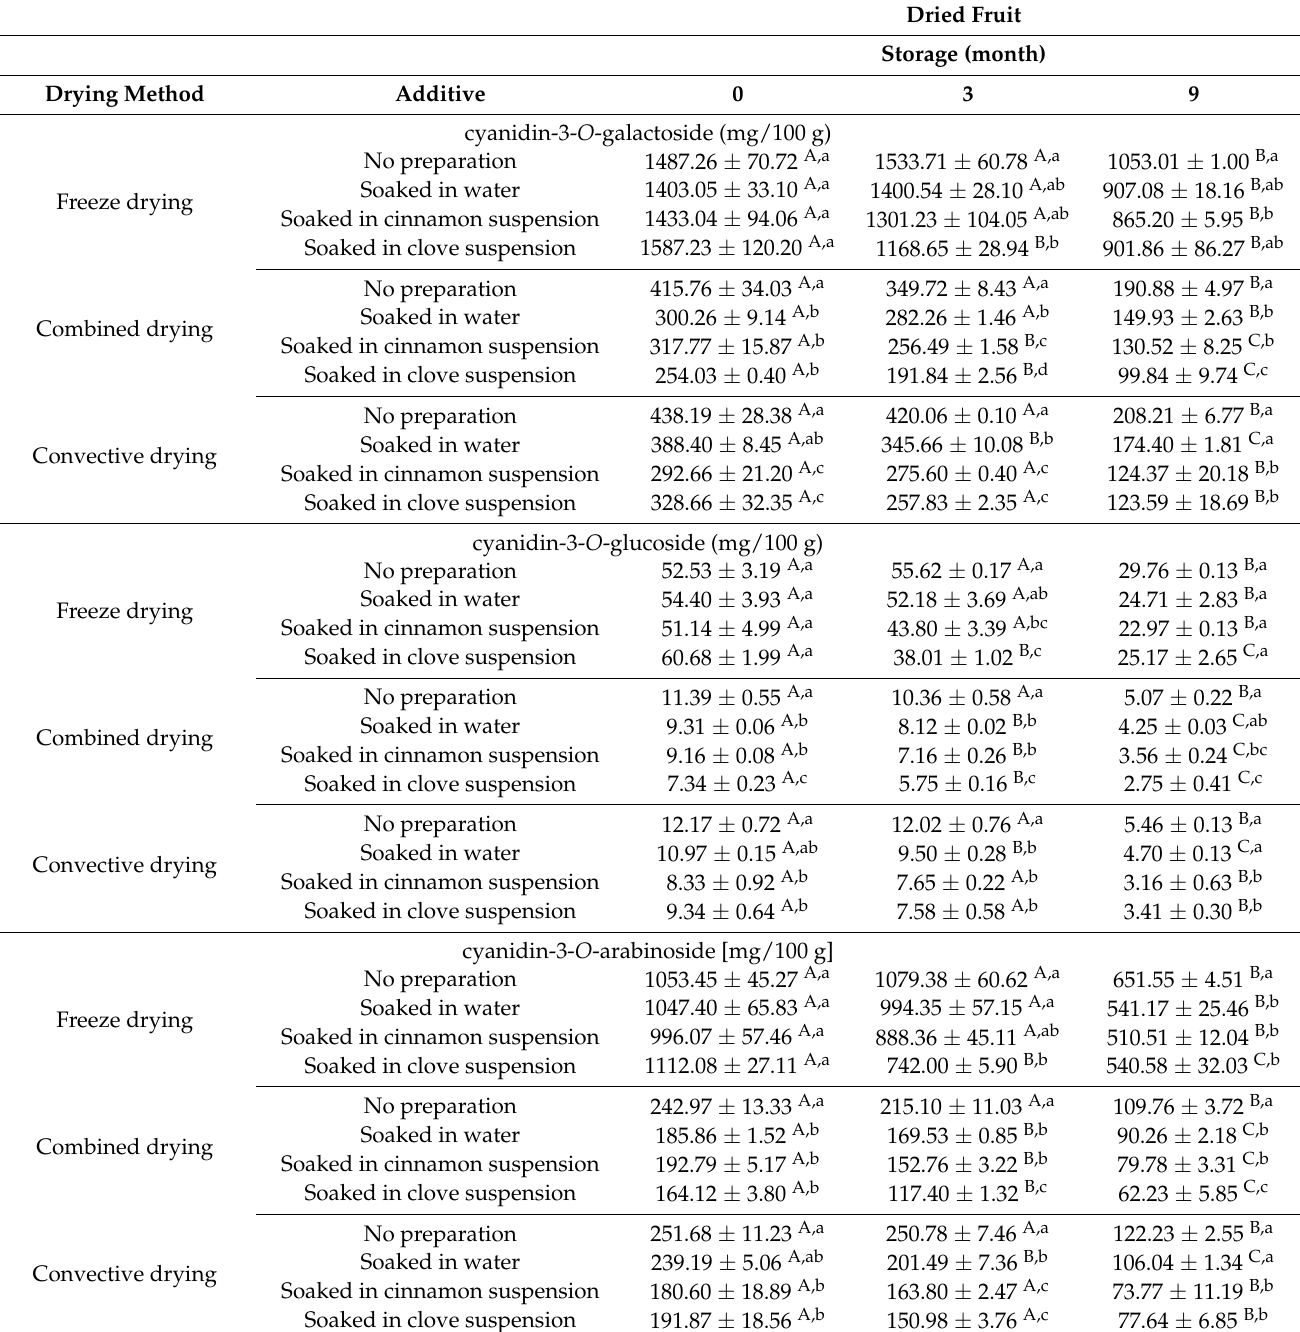
Table 1. Changes in anthocyanins content during storage of tested black chokeberry